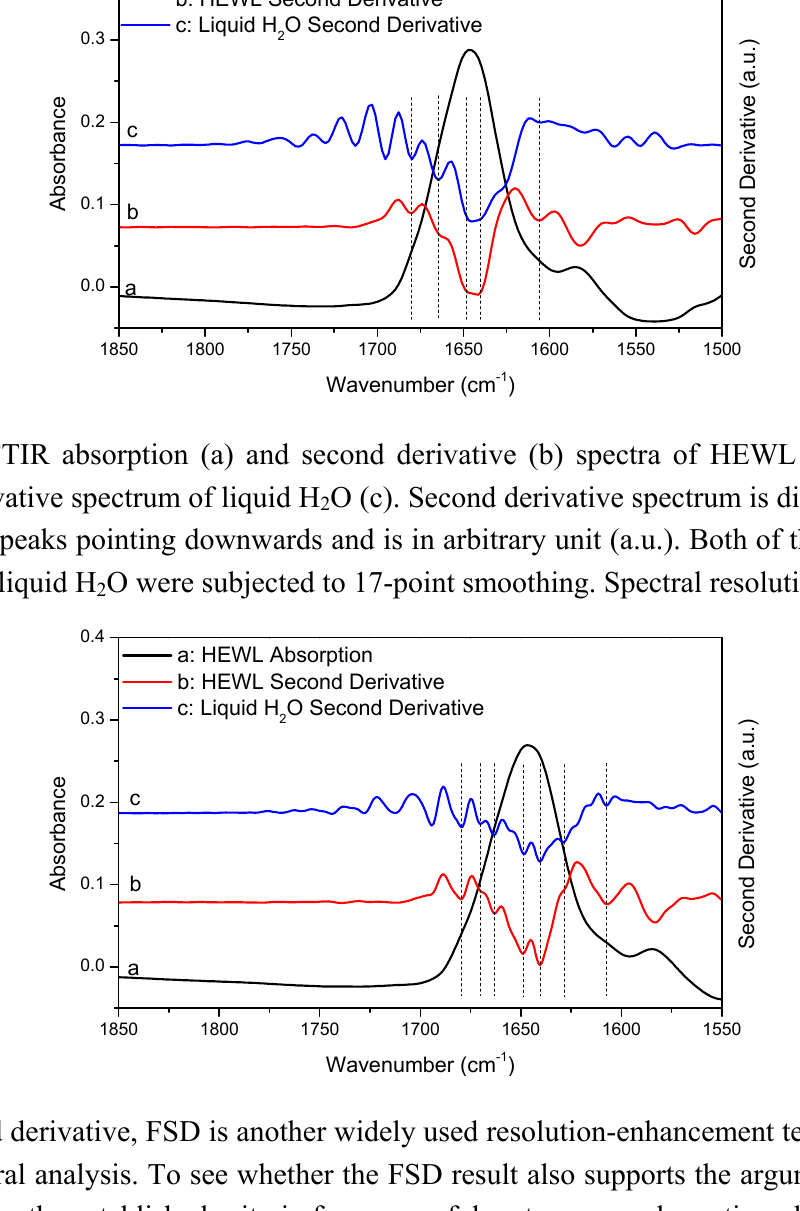
Figure 4. FTIR absorption (a) and second derivative (b) spectra of HEWL in D second derivative spectrum of liquid H O (c). Second derivative spectrum is displayed with its 2 resolved peaks pointing downwards and is in arbitrary unit (a.u.). Spectral resolution: 8 cm − 1 .